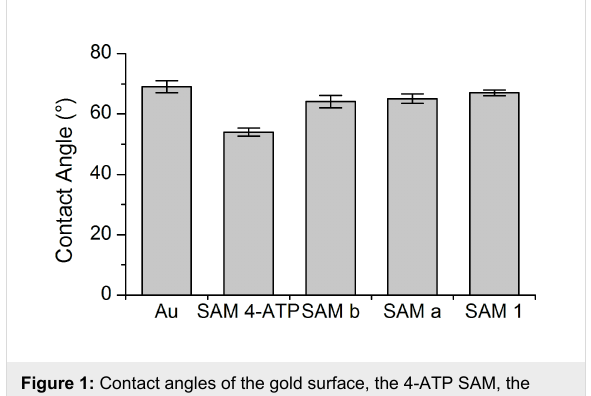
Figure 1: Contact angles of the gold surface, the 4-ATP SAM, the 4-ATP SAM after reaction with ArSO 2 NHOSO 2 Ar (Ar = 4-MeC 6 H 4 or 4-FC 6 H 4 ), respectively SAM a and SAM b and the sulfamide 1 SAM.